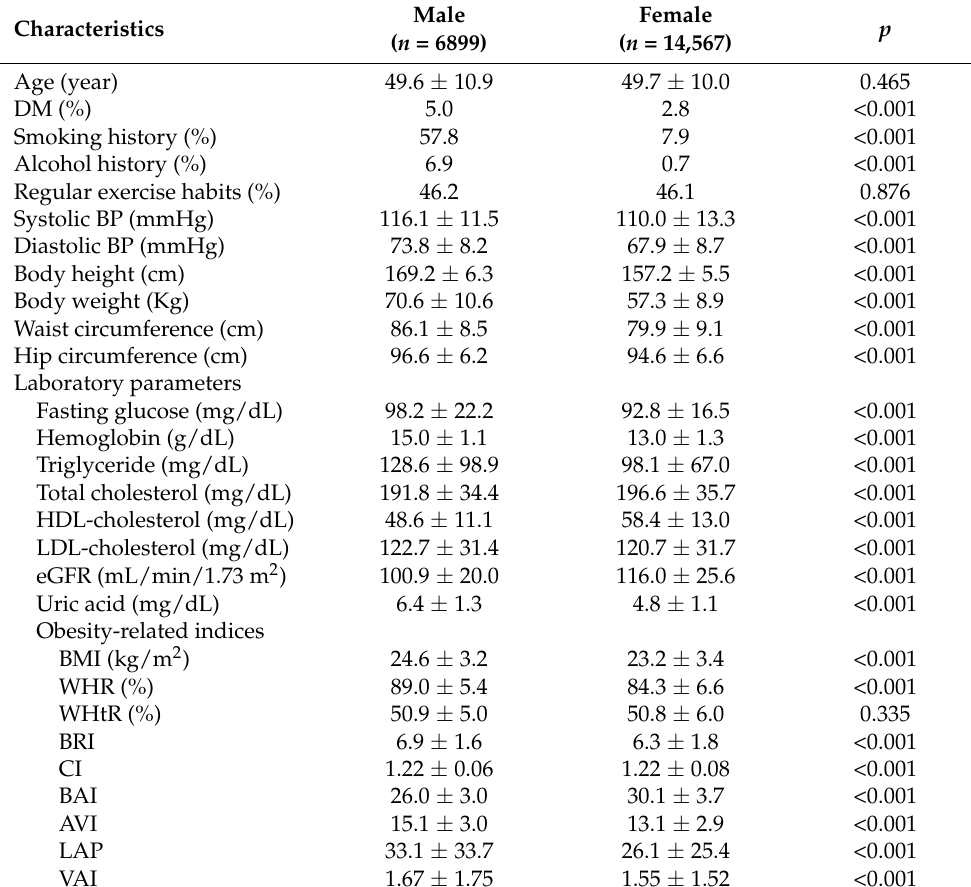
Table 1. Clinical characteristics of the study participants classified by